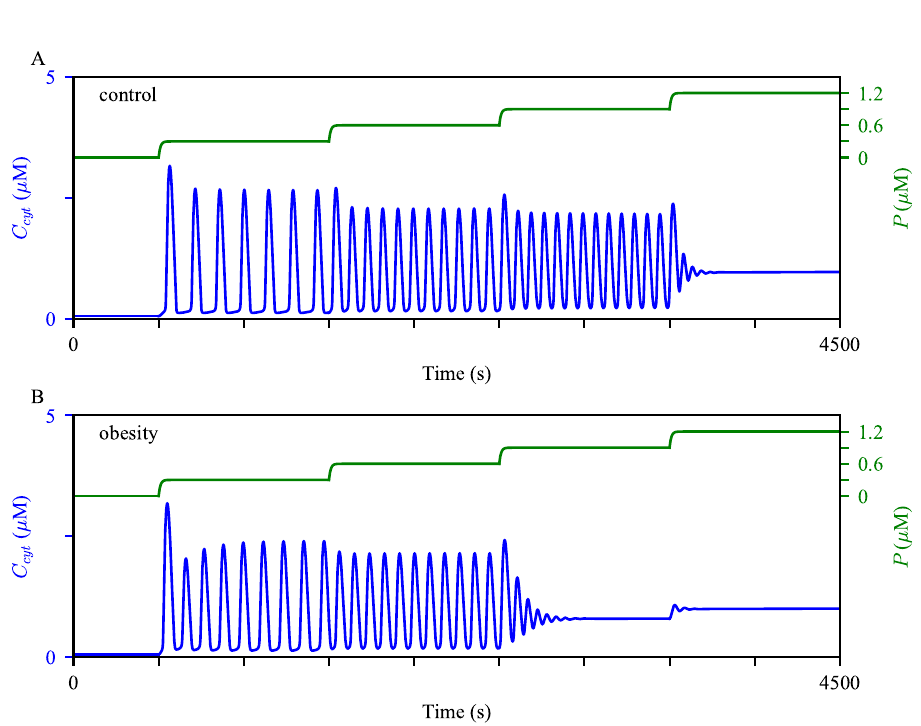
Fig 13. Robustness of Ca 2+ oscillations under different model conditions. We perturbed (A) the control model and (B) the obesity model with gradually increasing stimulation. Initially, P s was at 0 μ M, then was increased to 0.3 μ M, 0.6 μ M, 0.9 μ M, and then to 1.2 μ M at t = 500 s, 1500 s, 2500 s, and 3500 s, respectively. The cytosolic Ca 2+ concentrations are shown in blue, with the scale on the left y-axis. The green timeseries represent the IP 3 concentration, with the scale on the right